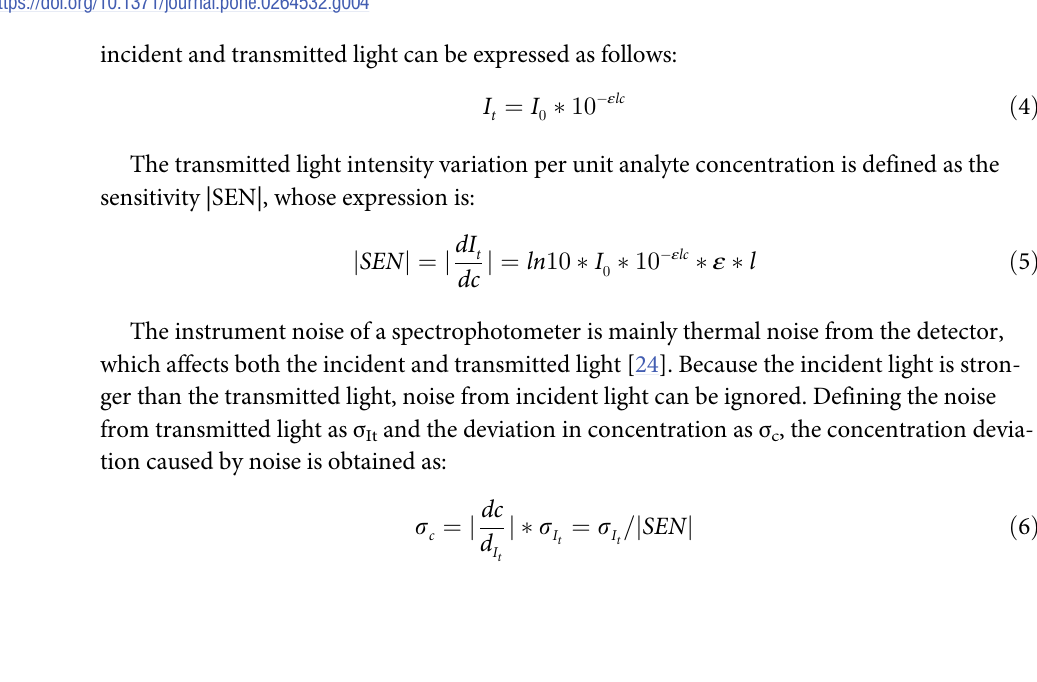
Fig 4. Spectra of an 80.0 g/L MnSO 4 solution measured at different SBWs. 0.1~3.6 nm, 0.5 nm increments. Inset is absorbance at approximately 401 nm at different SBWs (0.6~1.3 nm, 0.1 nm increments).